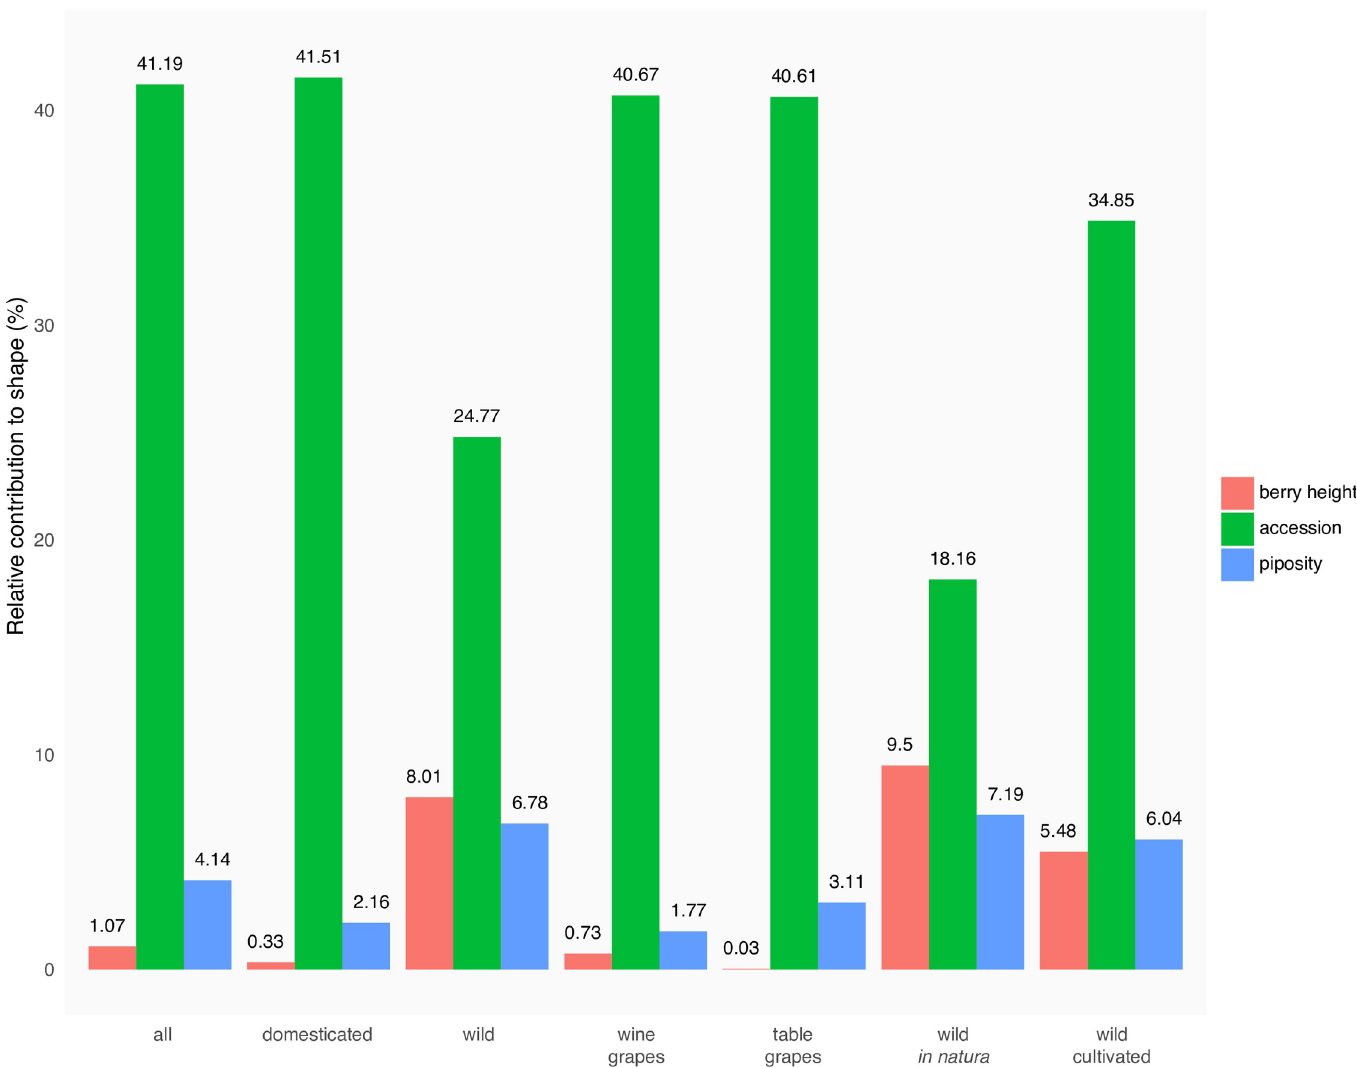
Fig 6. Relative contribution of berry height, accession and number of pips per berry (coloured bars) onto the shape of pips for different subsets.